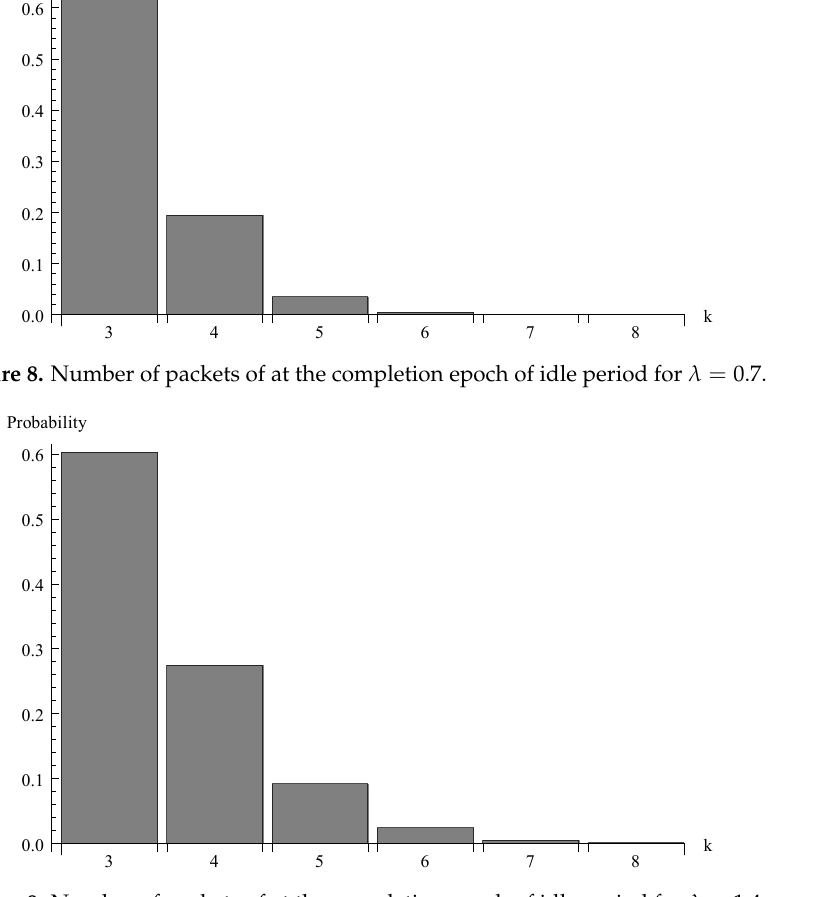
Figure 9. Number of packets of at the completion epoch of idle period for λ =